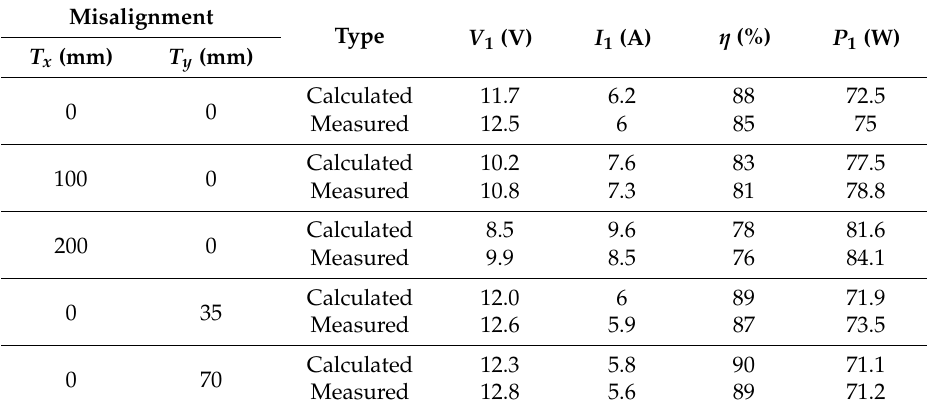
Table 2. Measured and calculated electrical quantities of the WPT system circuit when P L = 64 W.